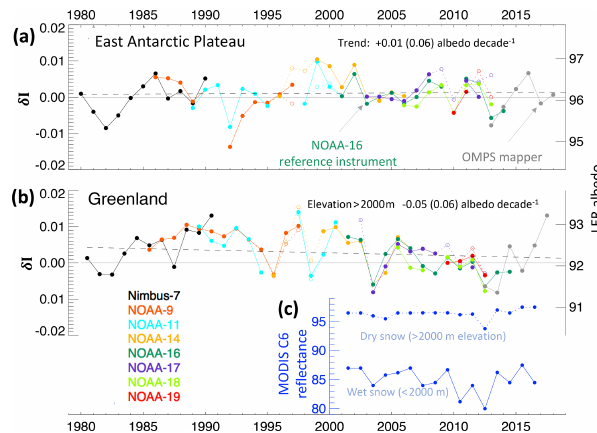
Figure 4. Inter-annual variability of our δI for the SBUV instru- ments (colored) and the OMPS Mapper (grey) over Antarctica (a) and interior locations over Greenland with ice surface eleva- tions above 2000m (b) . The right-hand axis shows the correspond- ing change in LER. Annual means plotted with solid circles only in- clude observations with correct grating drive positions; open circles also include those with grating drive errors that have been corrected (see text). The lowest panel (Fig. 4c) shows MODIS Collection 6 reflectance for Band 3 (459nm) at elevations above 2000m (dry snow conditions dashed trace) and below 2000m (wet snow condi- tions solid